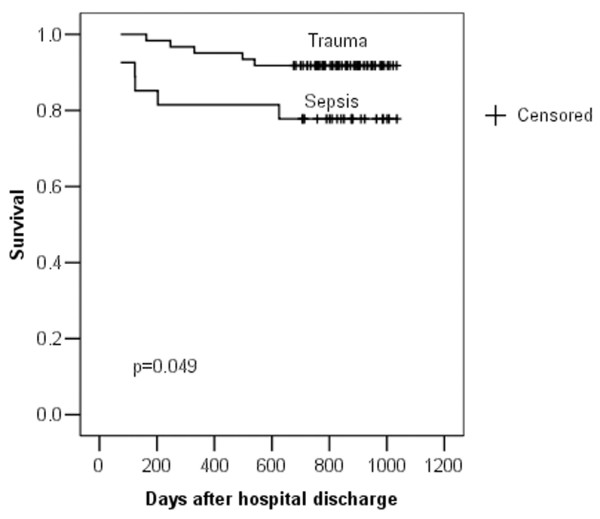
Post-hospital mortality. The Kaplan-Meier survival curve shows that patients with sepsis had higher post-hospital mortality than did patients with trauma.